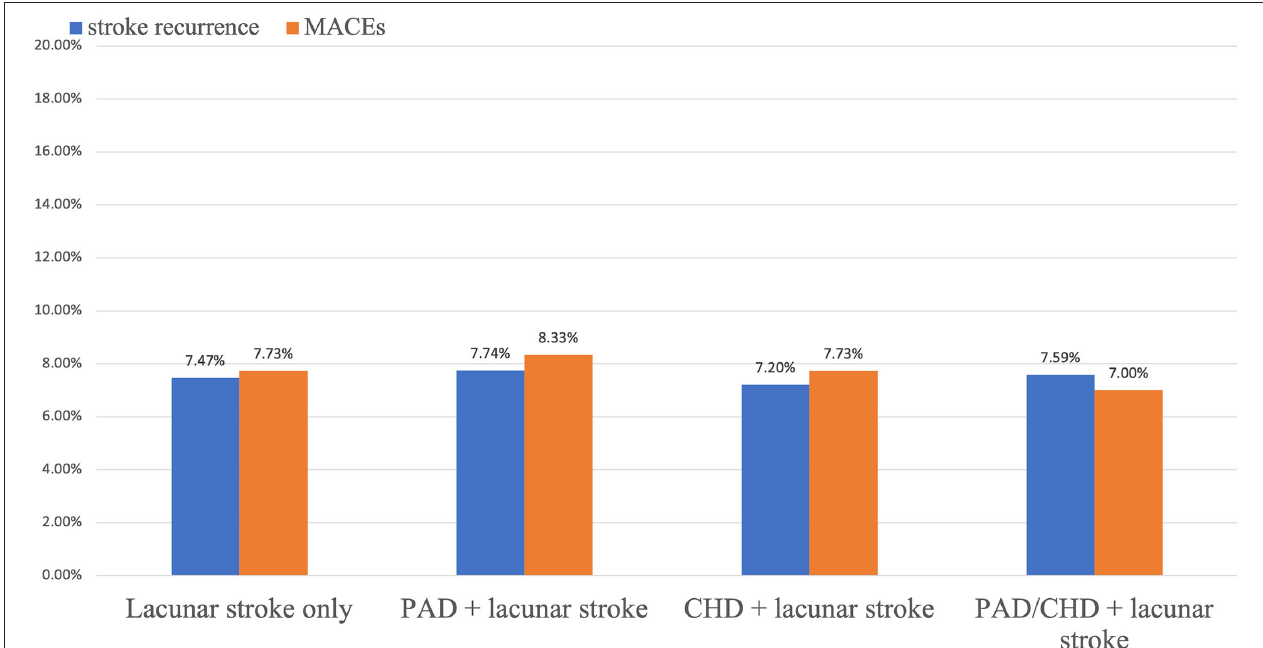
Frontiers in Neurology |